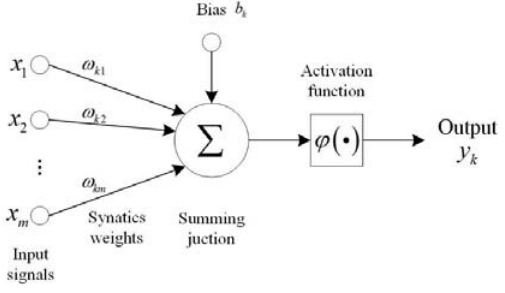
Figure 1. A general neuron model.